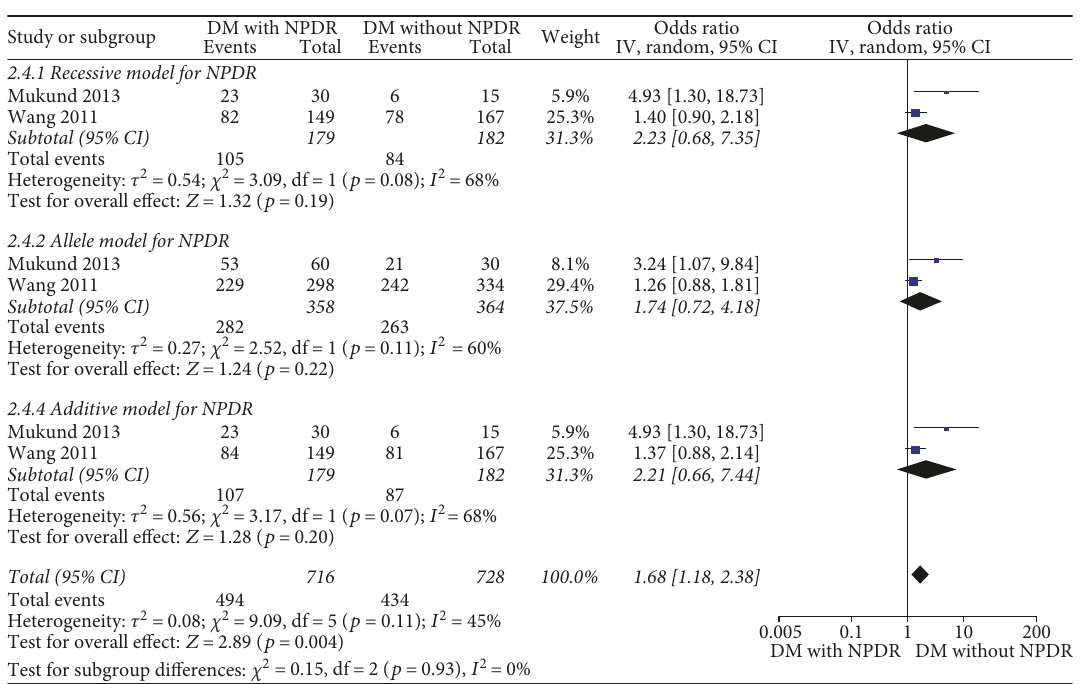
Figure 8: Forest plot for meta analysis comparing NPDR with DWR in di ff erent